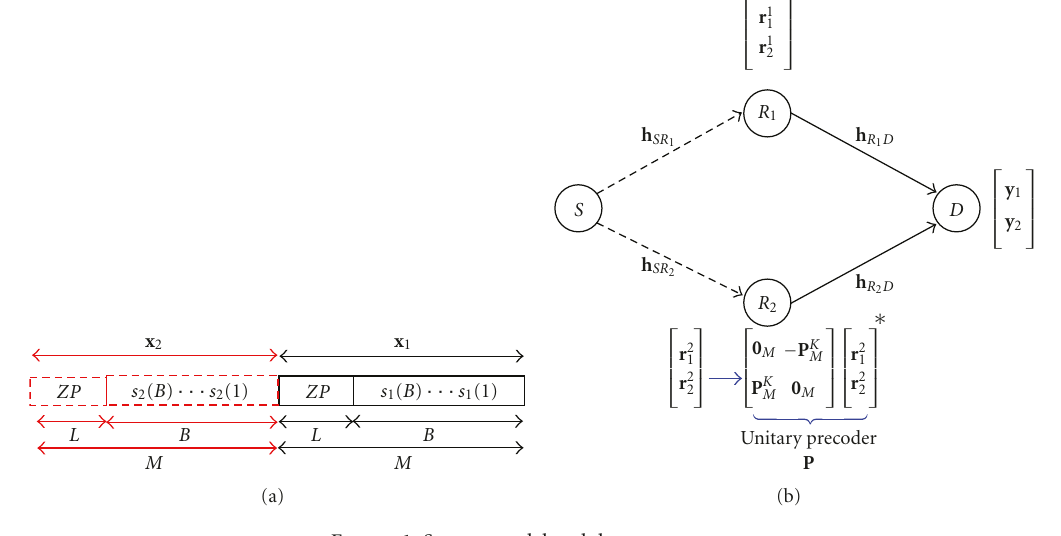
Figure 1: System model and data